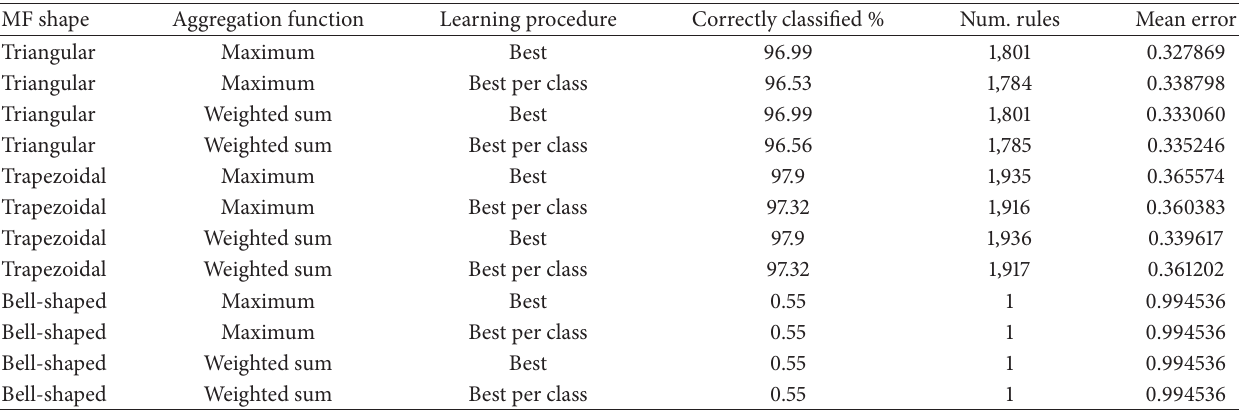
Table 2: Round 2. Data separated by gender for some species (see the Appendix); 3,660 patterns presented for use in training; NEFCLASS-J defaults for learning constraints and learning rate were kept; maximum number of epochs was 500, minimum number of epochs was 10, and number of epochs after optimum was